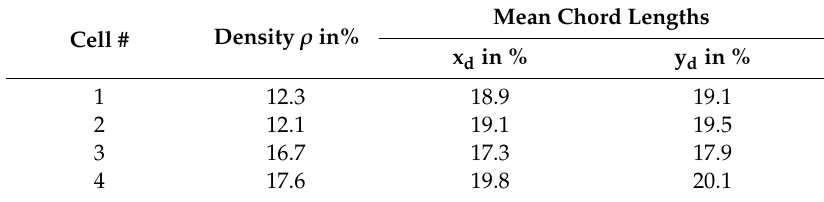
Table 2. Computed actin network densities and relative chord lengths for four